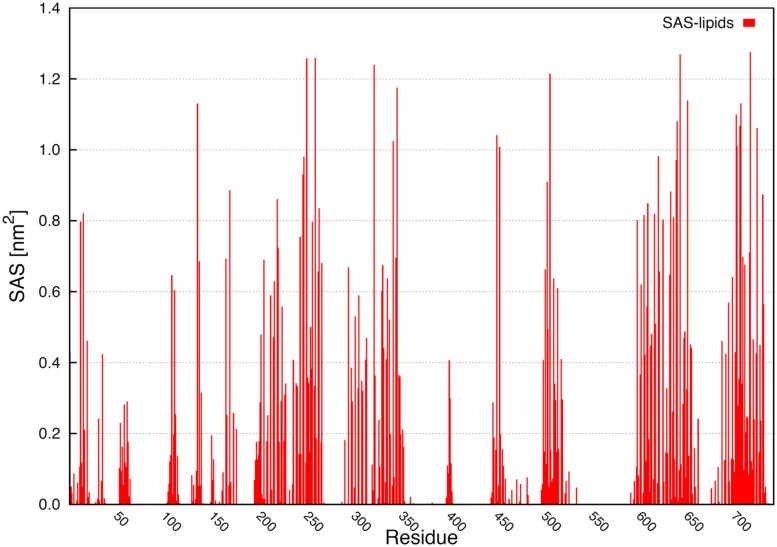
Solvent accessible surface area by residues exposed to the membrane inner core. The highest values correspond to amino acids totally exposed to membrane hydrophobic core.